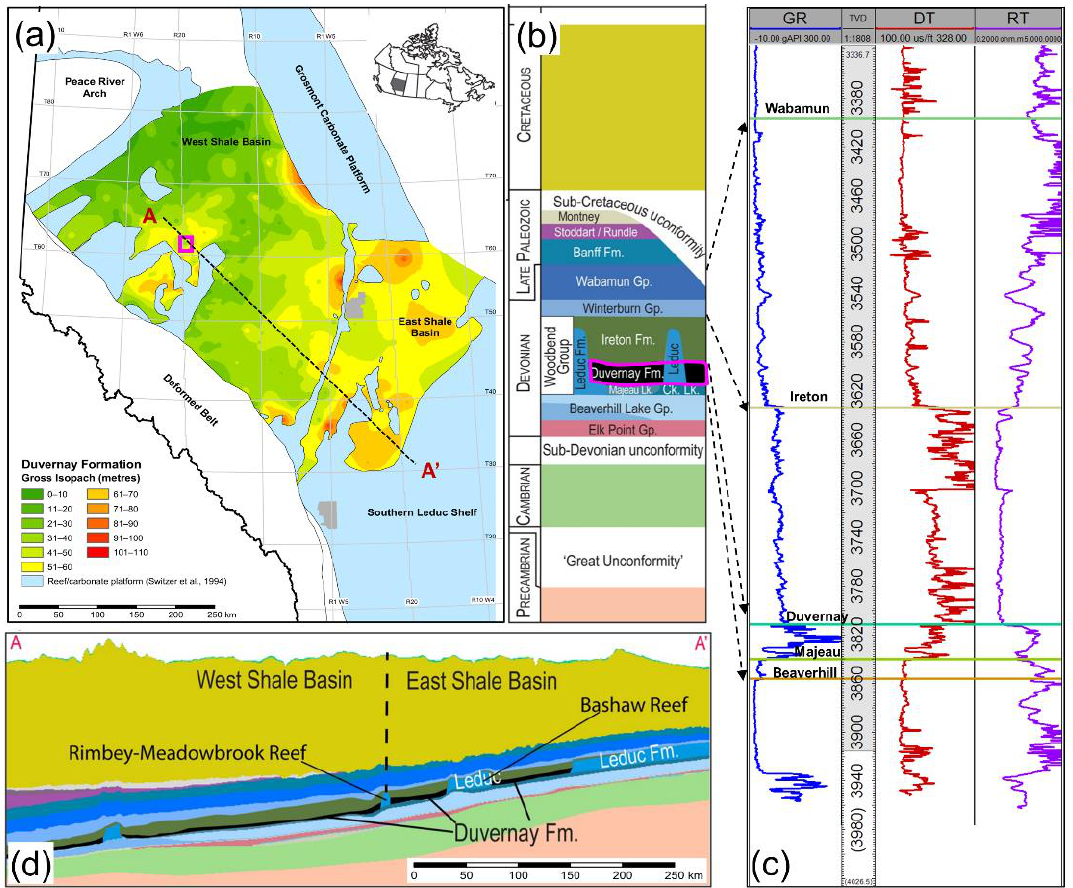
Figure 1. The geological information of the Duvernay formation. ( a ) Location of the West Shale Basin (WSB) and East Shale Basin (ESB). The examined region is marked by the small magenta box. ( b ) Stratigraphy of the studied region. The magenta polygon marks the Duvernay formation with the black shale lithology. ( c ) The logging response of associated formations. GR—Gamma ray; DT—Acoustic sonic; and RT—Formation resistivity. ( d ) The cross-sectional stratigraphy for lines A-A’ in ( a